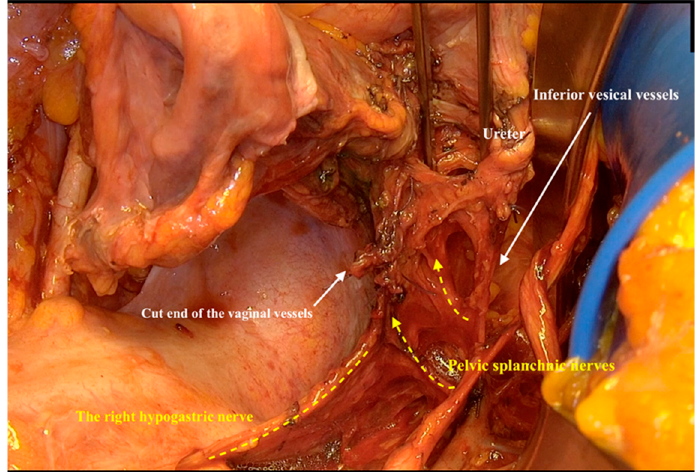
Figure 7. Exposing the inferior hypogastric plexus after resection of dorsal and lateral paracolpium.